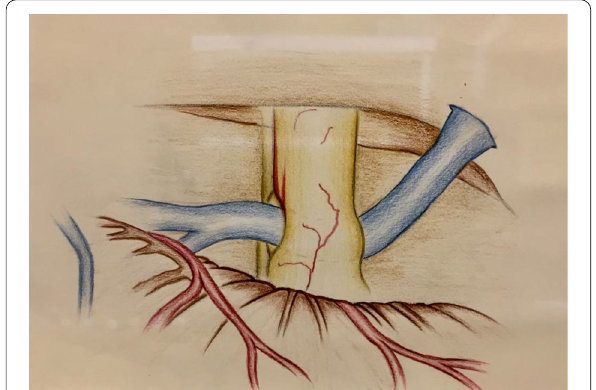
Fig. 4 Illustration of the neurovascular conflict caused by the vein passing through the trigeminal nerve itself at its root entry zone. “© 2020 [Asmaa Edres]. Used with